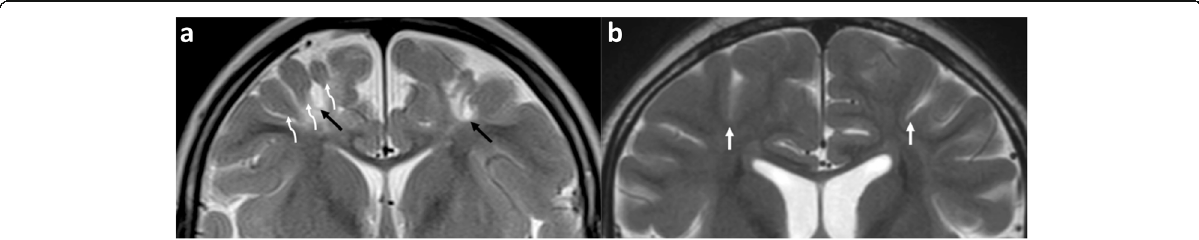
Fig. 2 a , b Ulegyria in a patient with partial-prolonged HII in prolonged labour ( a ) compared with normal gyral and sulcal pattern ( b ). Coronal T2-weighted image in a , a 4-year-old boy, who suffered a partial-prolonged HII demonstrating bilateral, symmetric localised atrophy in the parasagittal regions and abnormal underlying white matter high signal. There is ulegyria with overt thinning of the stems (curved white arrows) of the involved gyri and a resultant teardrop shape to the sulcus (black arrows). In comparison, the gyri in b , a normal 8-year-old girl, have parallel walls throughout their length and the sulci remain slit like from their surface to their depth (straight white arrows)